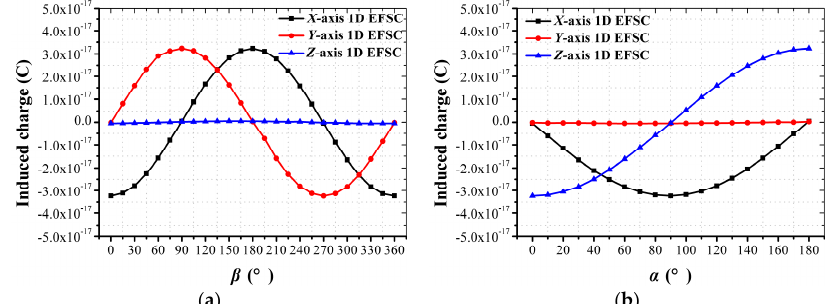
Figure 8. Simulation results of the proposed 3D EFS’s response to the electric field with different directions. ( a ) Induced charge along each sensing axis with respect to β when α is 90° and E 2 is 10 V/m; ( b ) induced charge along each sensing axis with respect to α when β is 0° and E 2 is 10 V/m.